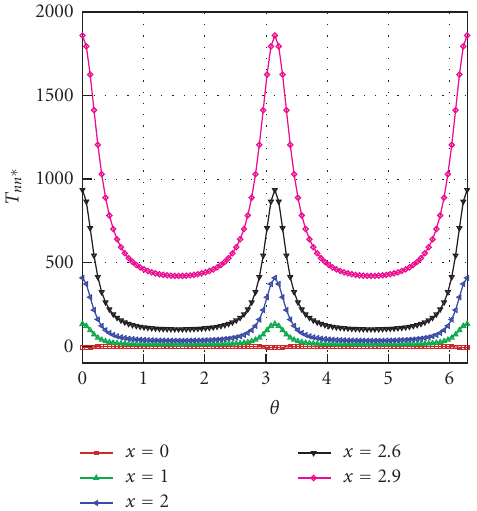
Figure 6.14. Dimensionless normal stress as a function of the polar angle θ for the di ff erent cross sections of the rear part of the ellipsoid shown in Figures 6.6–6.10 ( x ≥ 0). The normal stress is tension in the rear of the ellipsoid, with a strong tension near the trailing